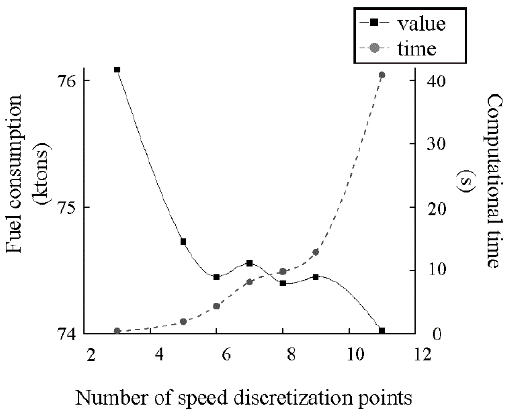
Figure 5. Relationship between solution value, algorithm runtime and the number of speed discretization points.